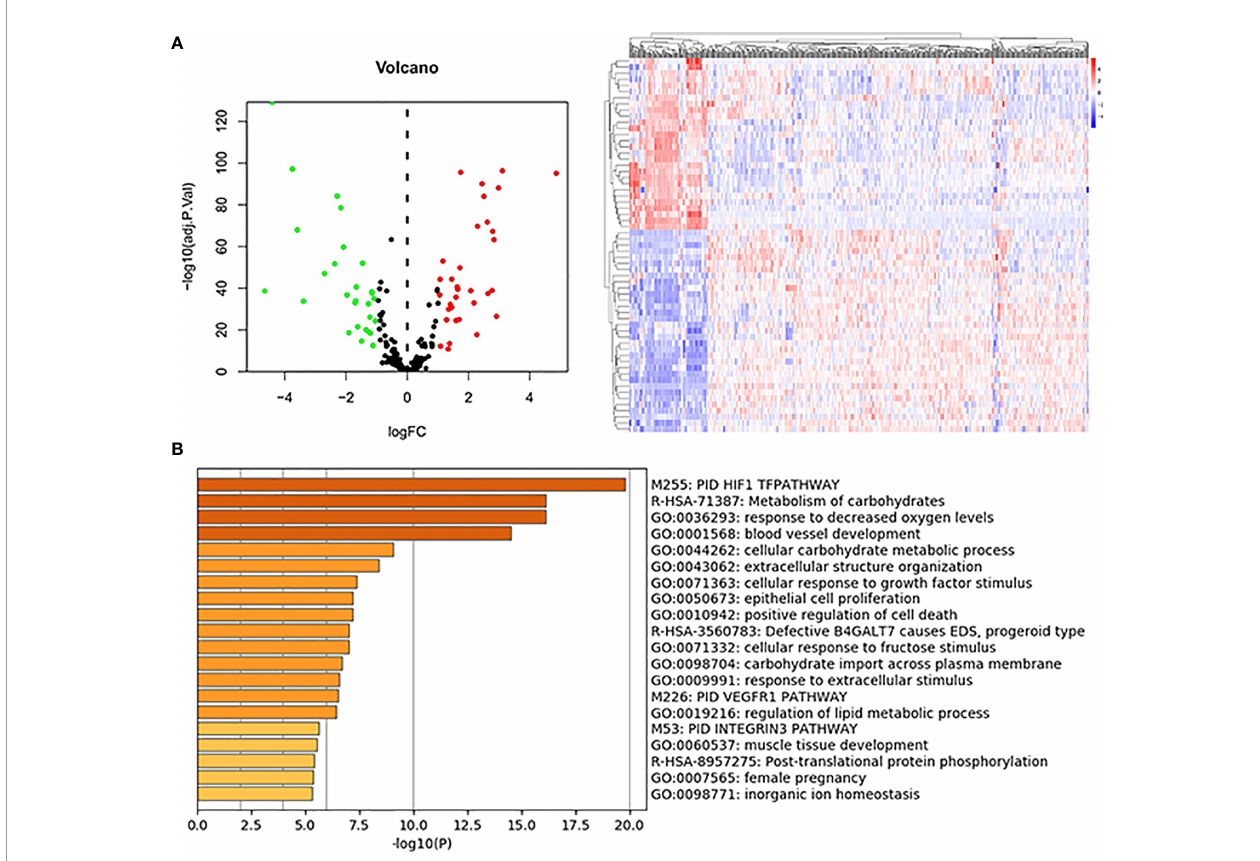
FIGURE 2 | DE-hypoxia-related gene identi fi cation and enrichment analysis. (A) Volcano plot and heatmap of the DE-hypoxia-related genes identi fi ed from the TCGA KIRC dataset. In the volcano plot, red dots represent upregulated genes, and green dots represent downregulated ones. (B) Enrichment analysis of DE- hypoxia-related genes by online tool Metascape (https://metascape.org/). The top 20 enriched terms are listed, and the color of the bar represents the value of -log10(P-value). TABLE 2 | The four-signature lncRNAs. LncRNA